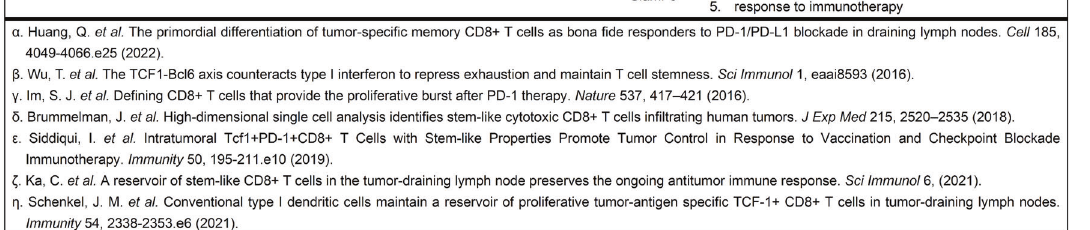
Fig. 1 a The mechanism of tumor draining lymph nodes-tumor speci fi c memory T cells (TdLN-T TSM ) response to PD-1/PD-L1 immune checkpoint blocking. As a precursor of TdLN-progenitor of exhausted T cells (T PEX ), T TSM is located upstream of differentiation and persistently recruit various exhausted T cell subpopulation located in the tumor microenvironment (TME). The antitumor effect of PD-1/PD-L1 antibody is dependent on T TSM cell subsets. The prerequisite for antitumor effect of PD-1/PD-L1 antibody is to fi rst amplify T TSM cell in draining lymph nodes, meanwhile promoting the differentiation into T PEX which subsequently differentiate into exhausted CD8 + T cells (T EX ). Finally, the progeny of these cells enters TME through peripheral circulation and plays an antitumor role. Created with BioRender.com. b A summary of published studies on stemlike memory CD8 + T cells which have similar functions to TdLN-T TSM . TdLN-T TSM tumour-draining lymph nodes- tumor speci fi c memory T cells, N.S. nothing special, T SL stem-like T cells, LCMV lymphocytic choriomeningitis virus, NSCLC non-small cell lung cancer, T PEX progenitor of exhausted T cells, ICB immune checkpoint blockade Signal Transduction and Targeted Therapy (2023)